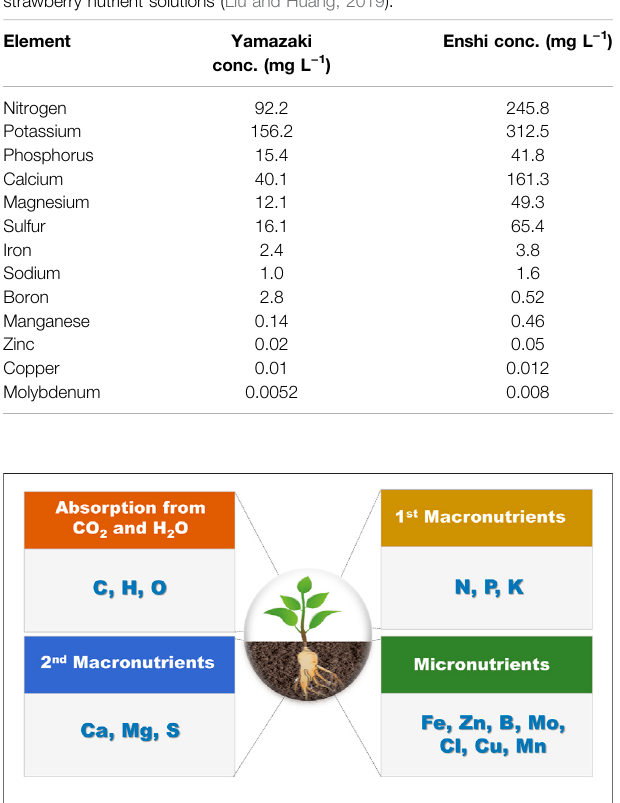
FIGURE 3 | Types of essential nutrients needed for plant